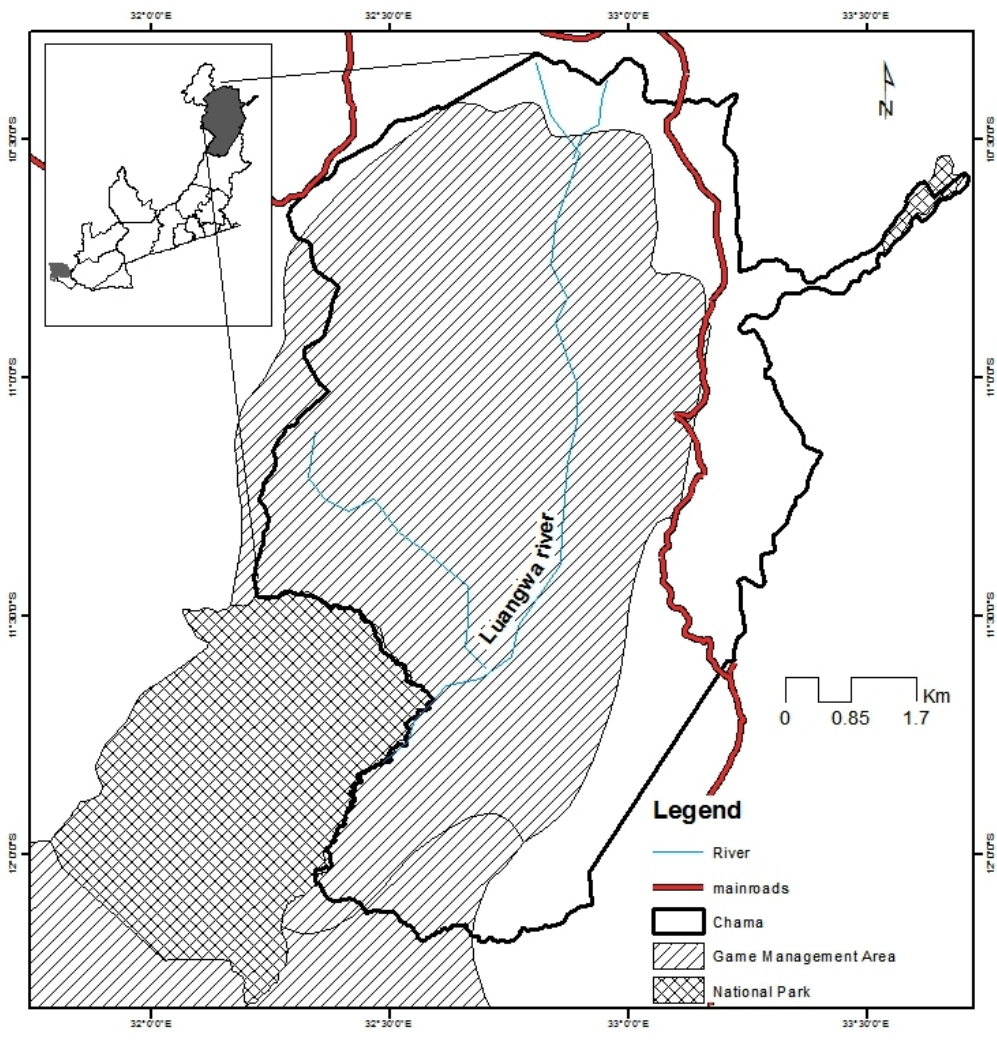
Figure 2. Chama district.